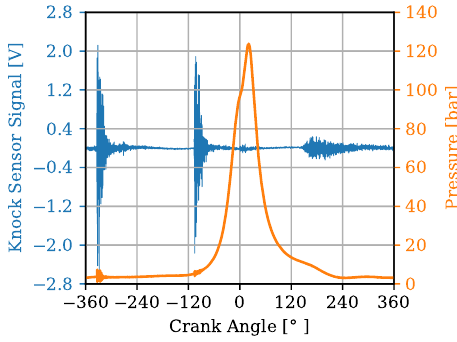
Figure 7. Whole cycle signals from − 360 to 360 °CA.